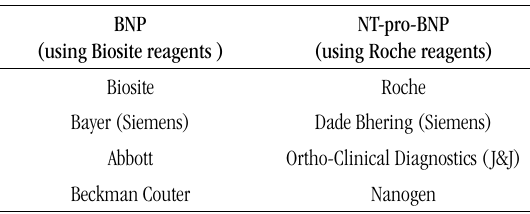
tABLE 2 – Commercially available tests for assessing natriuretic peptides